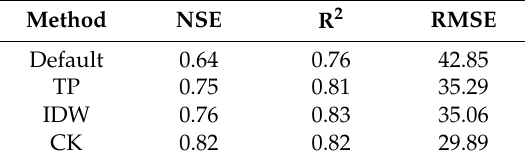
Table 3. Performance assessment of runoff modeling with different interpolated precipitation in